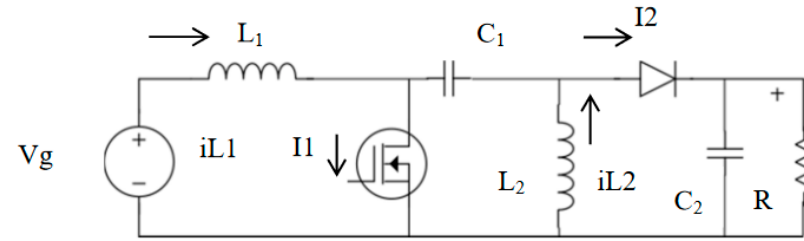
Figure 6. Circuit diagram.